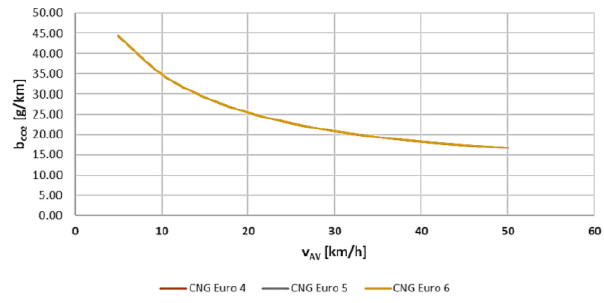
Fig. 9. CO 2 emission from CNG PCs for vehicle segments depending on average speed